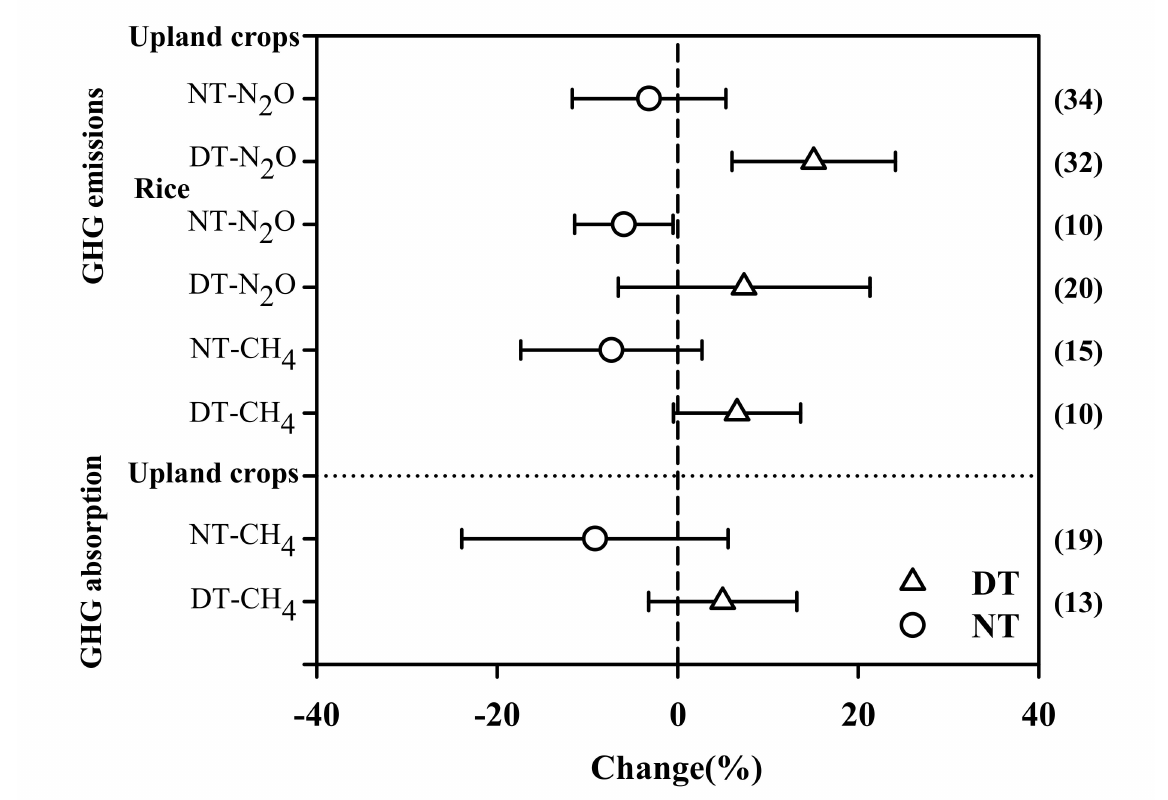
Figure 4. Changes in GHG emissions and absorption for different cropping systems under DT and NT compared with RT management plans. Triangles and circles indicate DT and NT, respectively. The number of observations (n) for each category is shown in parentheses. Error bars represent 95% CIs. Differences are considered significant when the CIs do not include zero. GHG, greenhouse gas; DT, deep tillage; NT, no tillage; RT, rotary tillage.